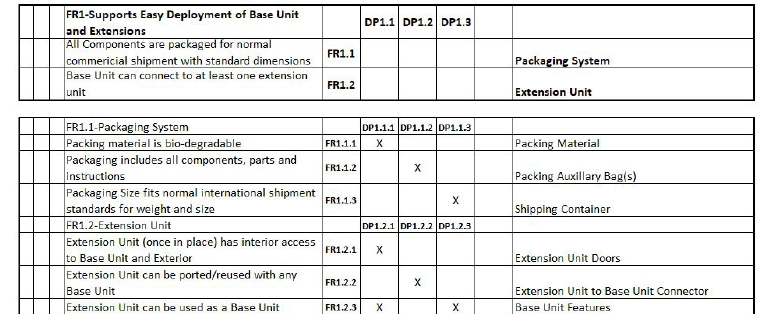
Figure 19. AD Top-Level Design Mapping of DPs for FR1.